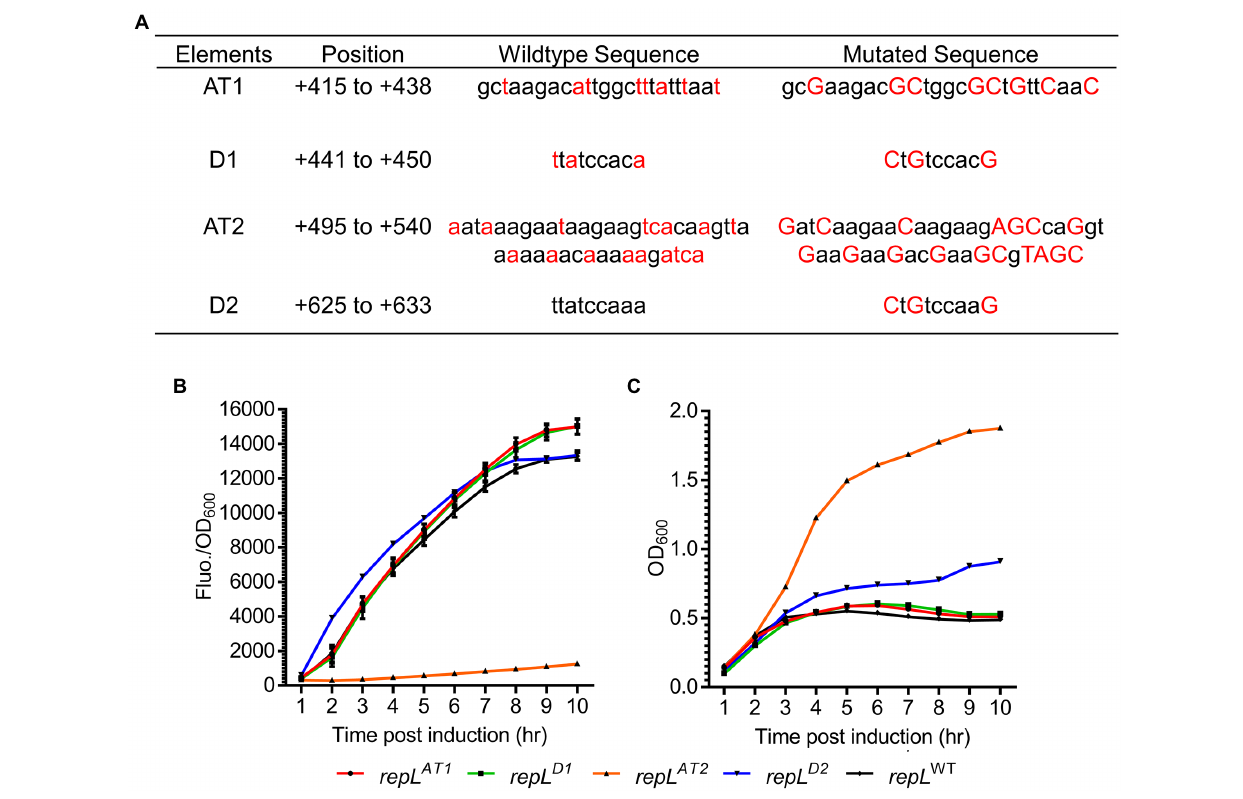
FIGURE 3 A repL AT2 allele significantly reduced the RepL-mediated GFP signal amplification. (A) Two A/T-rich regions termed AT1 and AT2, as well as two DnaA binding sites termed D1 and D2, might be important for RepL-mediated DNA replication. Synonymous base substitutions were introduced into a repL gene via PCR without affecting the amino acid sequence (i.e., codon-optimisation). The mutated bases (in red uppercase) as well as the wildtype sequence (in black lowercase) were shown. The position of these elements within the repL open reading frame (ORF) were shown. (B) The GFP fluorescence intensity per OD 600 (FIuo./OD 600 ) and (C) OD 600 of TOP10 cells transformed with a gfp.repL WT (black line with black diamonds) , gfp.repL AT1 (red line with black circles) , gfp. repL D1 (green colored line with black rectangles) , gfp.repL AT2 (orange line with black triangles) , or gfp.repL D2 gfp (blue line with black triangles) reporter plasmid, at 1 to 10 hpi with 1.33 × 10 − 4 M of L-arabinose. All GFP fluorescence intensity were normalized to that of TOP10 cells transformed with an empty plasmid without gfp and repL genes. Induction assays were performed with 3 biological replicates and 4 technical replicates. Data were presented as mean ±